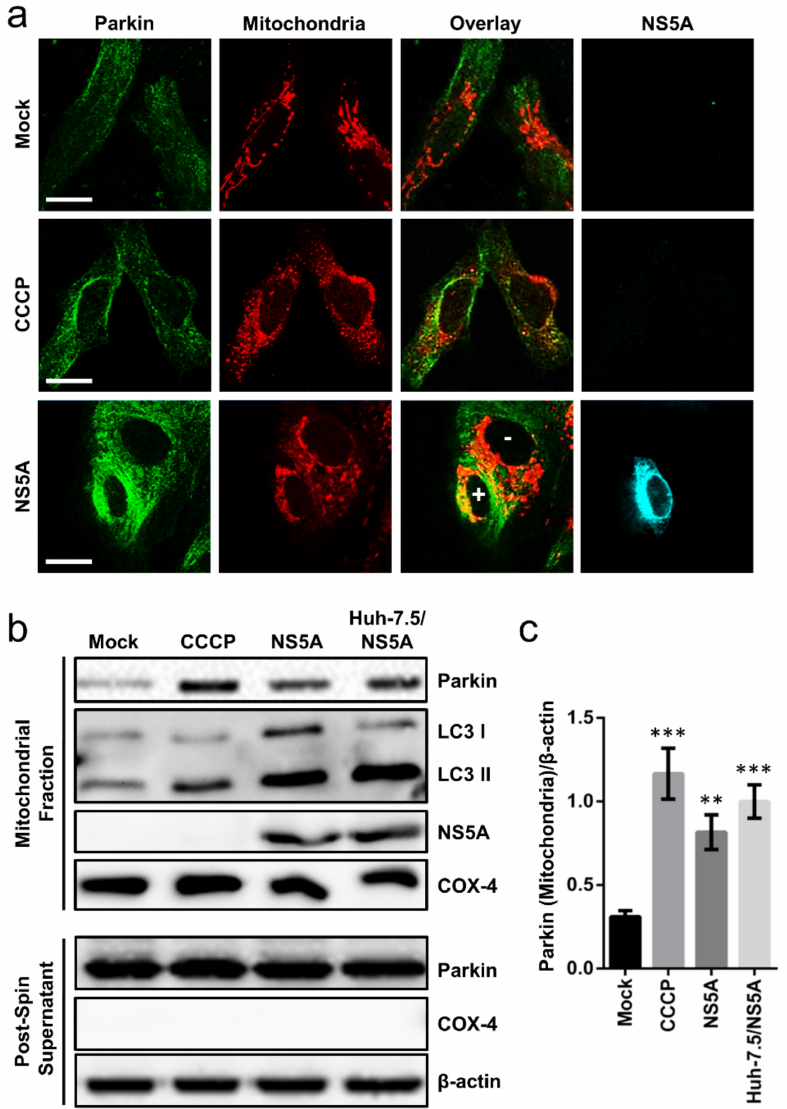
Figure 3. NS5A induces mitophagy. ( a ) Huh-7.5 cells were seeded on glass slides and transfected with NS5A for 3 days. The cells were subsequently pre-stained with MitoTracker Deep Red and then immunostained with anti-Parkin and anti-NS5A antibodies. Magnification = 630 × ; scale bar = 20 µ m. The positive (+) and negative ( − ) symbols indicate detection of NS5A expression. ( b ) Huh-7.5 cells were seeded in a 10 cm dish and transfected with NS5A for 3 days. Cells were harvested and the mitochondrial fraction was separated using the Mitochondrial Isolation Kit for Cultured Cells, after which an immunoblot was performed for Parkin translocation and LC3 lipidation. Parkin expression in the post-spin supernatant was included for comparison. COX-4 served as mitochondrial marker. ( c ) Densitometry quantification of the mitochondrial fraction Western blot in ( b ). CCCP (10 µ M) treatment on naïve Huh-7.5 cells was included as positive control. Results are from 3 independent repeats with error bars indicating mean ± SD; representative micrographs and Western blots are shown. β -actin served as a loading control for all analyses. Asterisks (*) denote statistical significance compared with mock: ** p < 0.01; *** p <